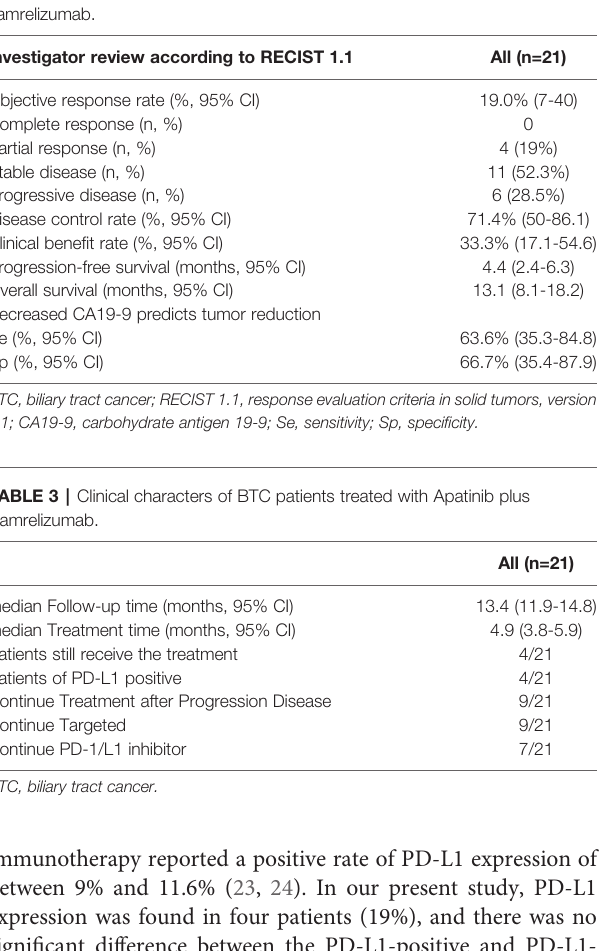
TABLE 4 | Treatment-related AEs in all patients with biliary tract